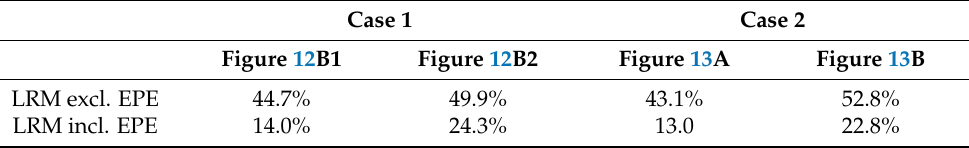
Figure 12. Electric-field distributions of Case 1 within the x,z-plane of the tumor model in Figure 5. ( A ) An example of high-resolution electric-field distributions excluding EPE. Filled contours were plotted to maintain the overview, since the electric-field strength varies within the contours. Note that the grey rectangles and the large, dashed circle illustrate electrodes and tumor, respectively. ( B ) Electric-field distribution of the high-resolution model (black line), and low-resolution models excluding EPE (+) and including EPE (*) along the lines O 1 ( B1 ) and O 2 ( B2 ). Table 1. Mean of the deviations of the electric-field distributions of the low-resolution models (LRMs) ex-/including EPE relative to the electric-field values at the corresponding position within the high- resolution model within a radius of 15 × 10 − 3 m from the center (a volume that includes the whole tumor and a part of the healthy